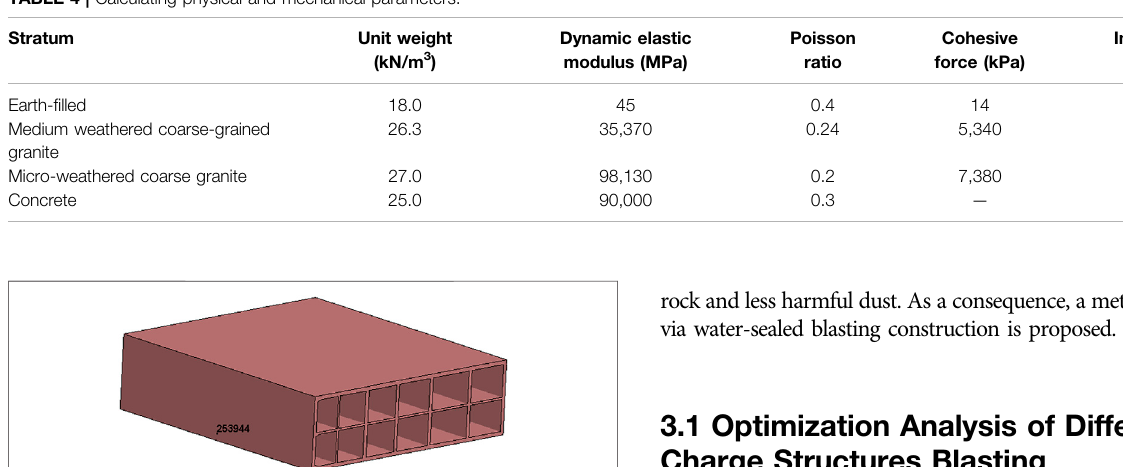
TABLE 4 | Calculating physical and mechanical parameters.